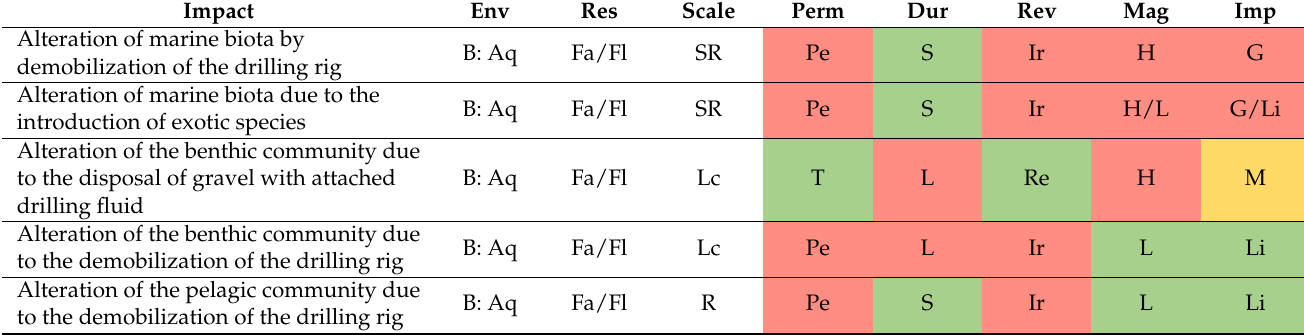
Table 2. Effective impacts during drilling